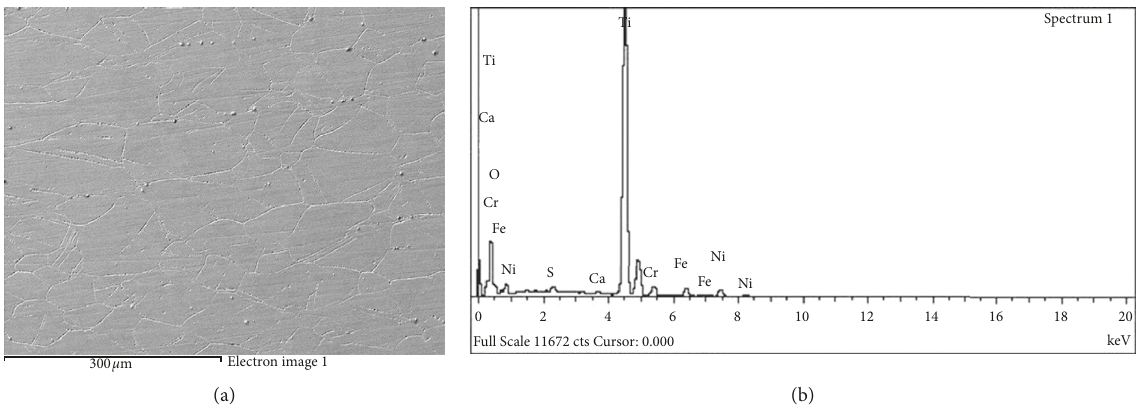
Figure 13: SEM images of inclusions and compositions in the near fracture zone of the HAZ.